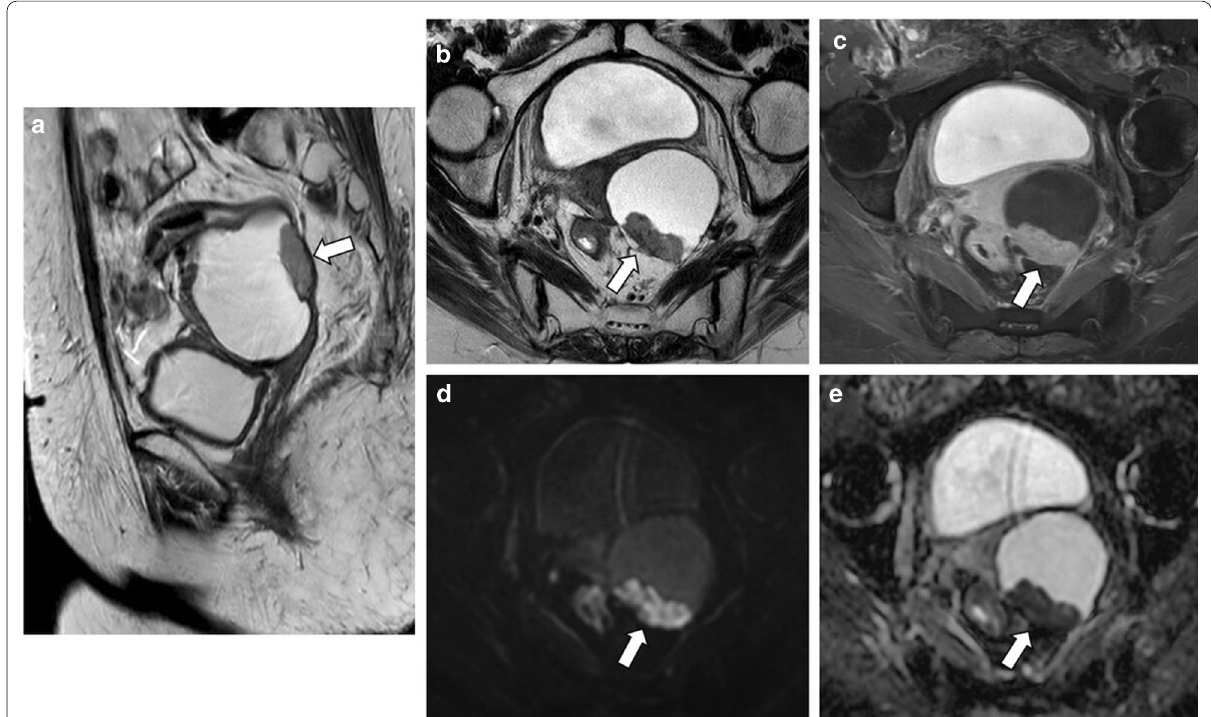
Fig. 9 Bilateral LGSC in a 58-year-old female. Sagittal and axial T2-weighted MR images ( a , b ) and axial T1-weighted MR image with fat saturation, after gadolinium administration ( c ) demonstrate a left cystic adnexal tumour with solid parietal components (arrows). Axial b -1000 s/mm 2 diffusion-weighted image ( d ) and ADC map ( e ) show diffusion restriction in the parietal nodule